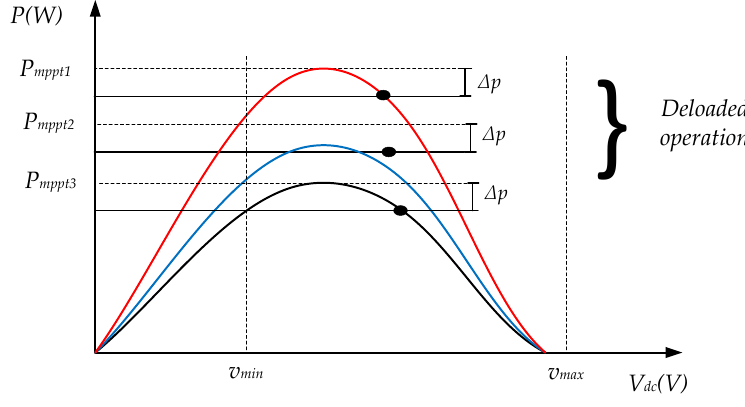
Figure 11. Deloading operation in PV